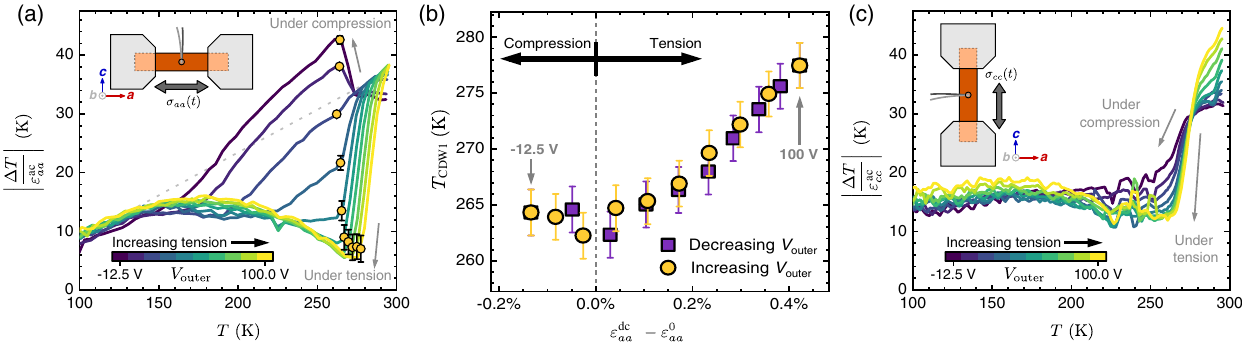
FIG. 3. Elastocaloric effect results for a sample of ErTe 3 with uniaxial stress (a) Magnitude of the elastocaloric response with stress parallel to the a axis as a function of temperature and offset voltage. The critical temperature T (circles) is extracted from an CDW 1 extremum in the second derivative. Inset: schematic of the experimental setup. The dotted line is a guide to the eye for a linear background independent of strain. The anomaly at T rises above this background for compressive stresses, but falls below this CDW 1 background for large enough tensile strain. (b) Critical temperatures T extracted from (a) as a function of dc offset strain, shown for CDW 1 toward either compressive or both increasing and decreasing PZT voltage steps. The critical temperature rises as one departs from ε 0 aa tensile strain. (c) Elastocaloric effect with stress parallel to the c axis. Tension increases the height of the critical anomaly, but no switching behavior is